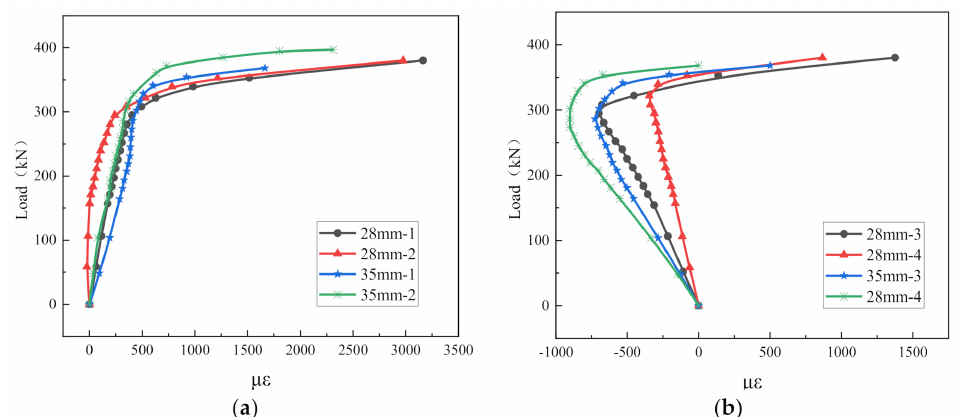
Figure 8. ECC surface load–strain curve of 16 mm stud and 100 mm spacing specimen: ( a ) Upper measuring points (1, 2 measuring points); ( b ) Lower measuring points (3, 4 measuring points).